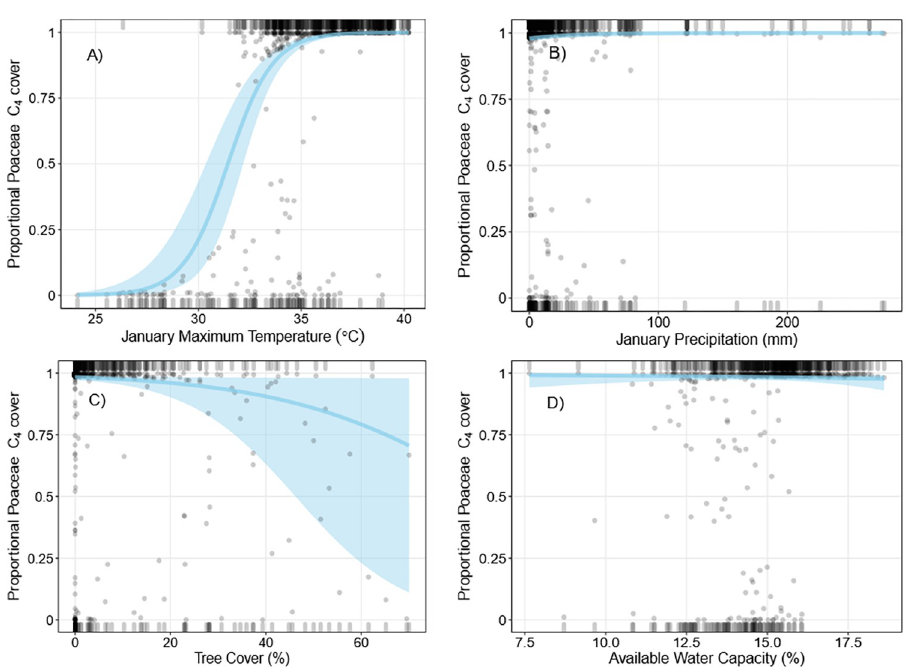
Fig 3. Binomial logistic regressions of proportional C 4 Poaceae cover. Grey points are partial residuals, blue lines and shaded bands are predicted outcomes of the regression and 95% confidence intervals respectively, and rugs were drawn to indicate observations with positive residuals (top of the plot) or negative residuals (bottom of the plot). For each plot (A-D), independent variables not depicted on the x-axis are held constant at their median value.